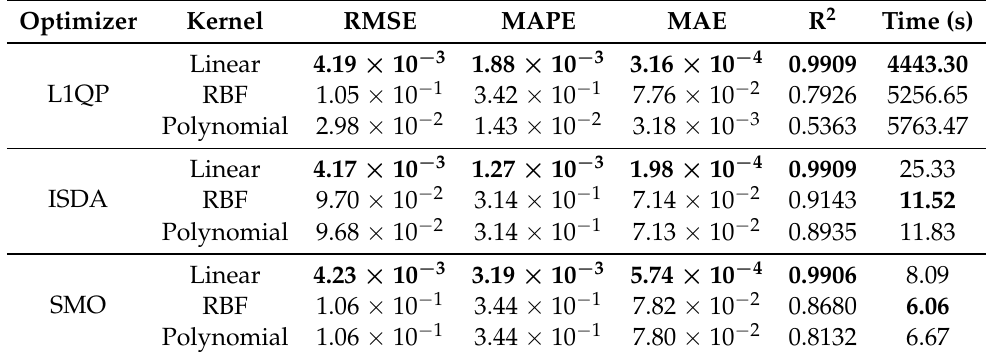
Table 5. Evaluation of ensemble bagging